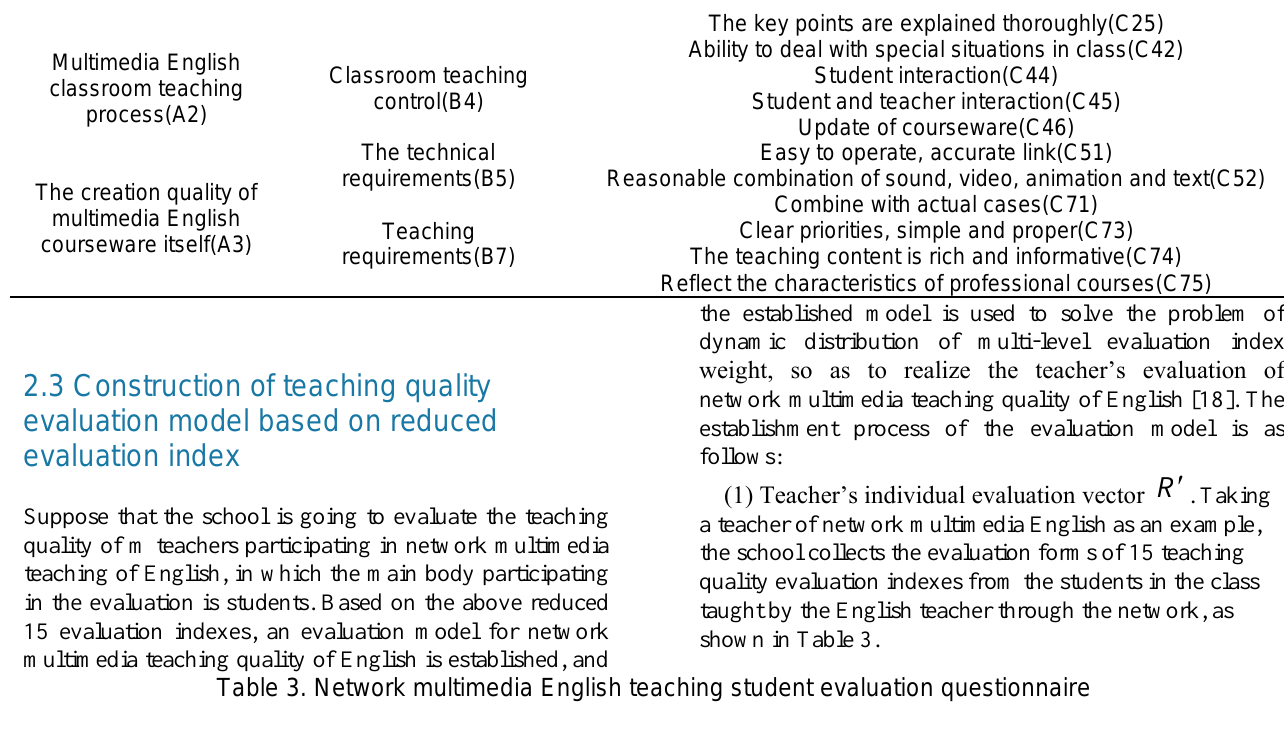
Table 3. Network multimedia English teaching student evaluation questionnaire